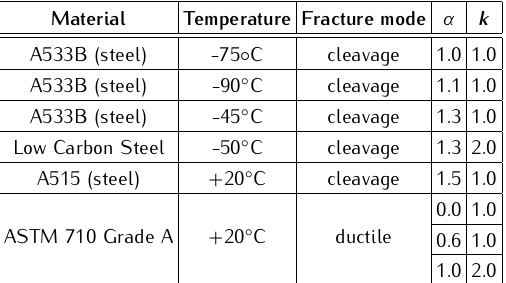
Table 1. Some values of the α and k parameters in Eq. (9) [8,